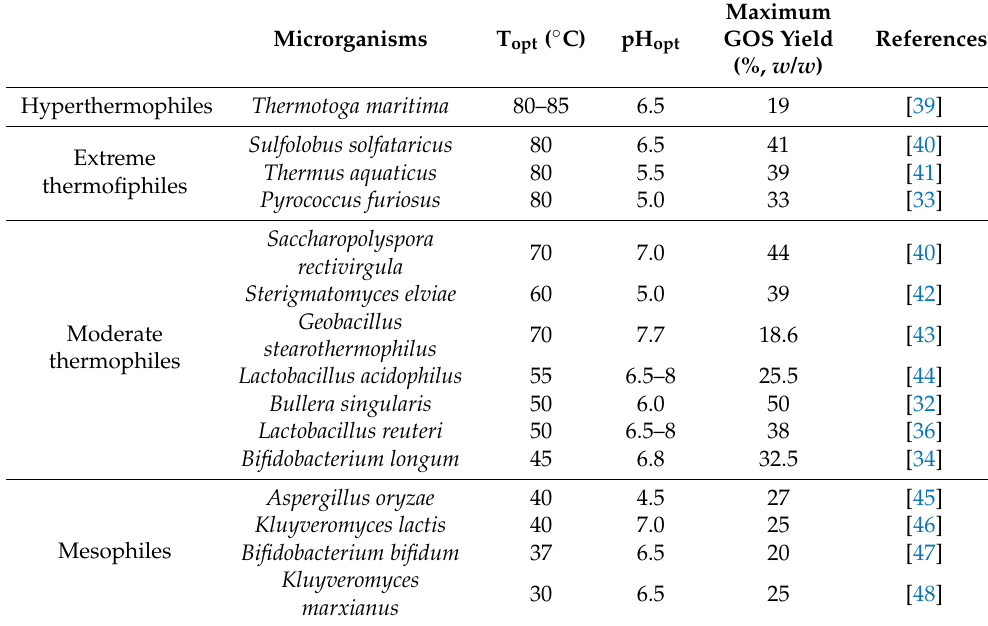
Table 1. The optimum of temperature (T opt , ◦ C) and pH (pH opt ) of microbial β -galactosidases with transgalactosylation